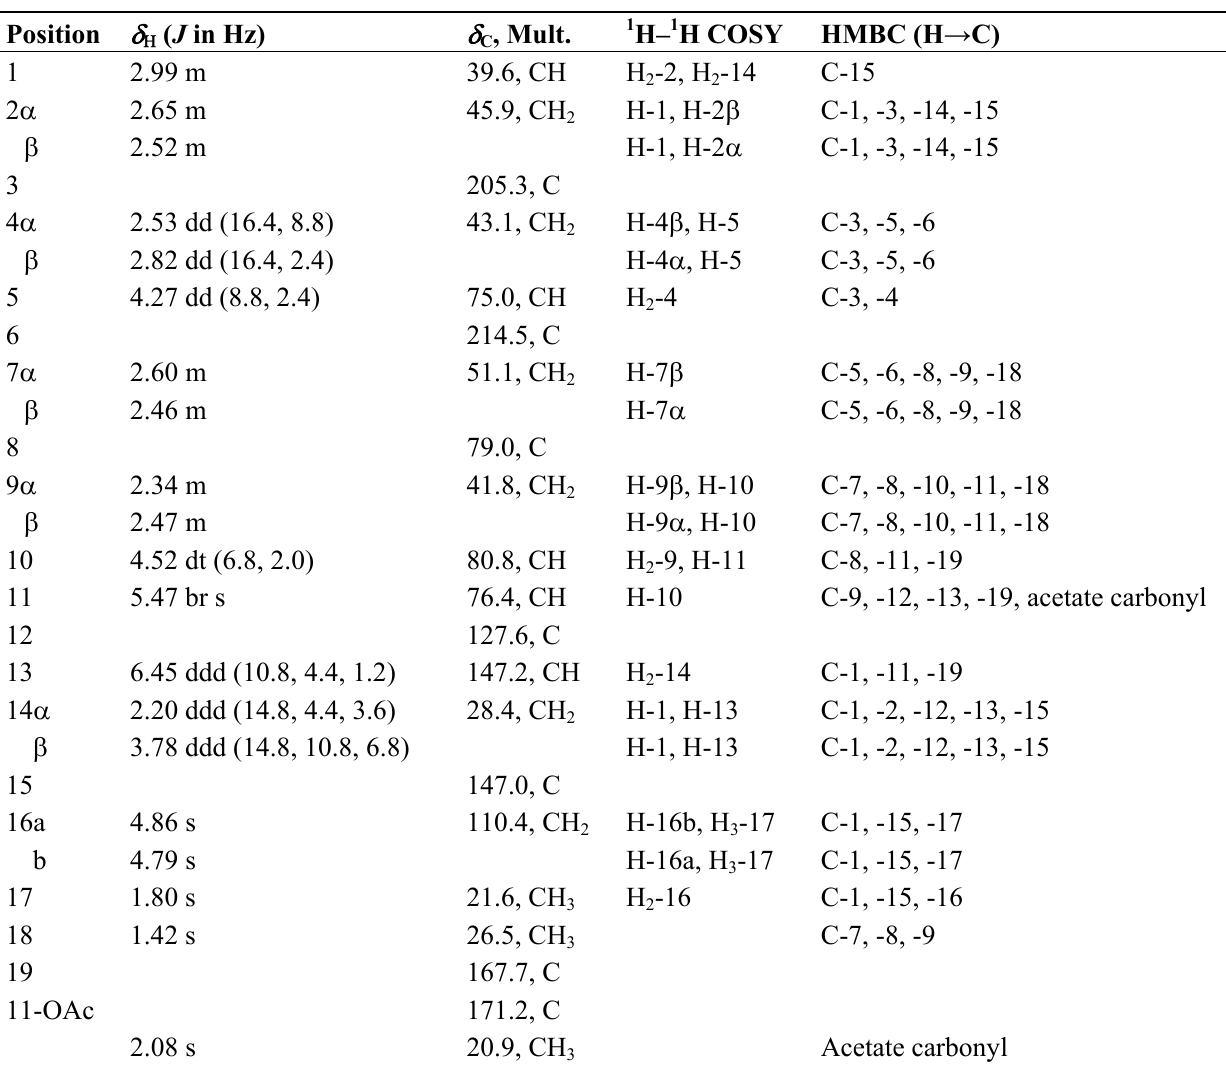
Table 1. 1 H (400 MHz, CDCl HMBC correlations for norcembranoidial diterpene 1